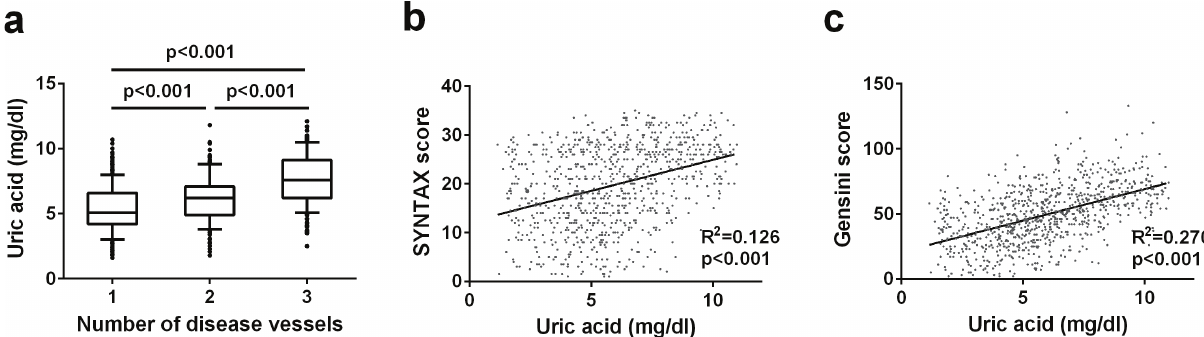
Fig. 2. Relationship between the UA level and severity of ACS patients. (a) UA levels in patients with different number of diseased vessels. Solid black line indicates median, box indicates interquartile range, and lower and upper whiskers indicate 10–90% range. (b) Relationship between the UA level and the SYNTAX score. (c) Relationship between the UA level and the Gensini